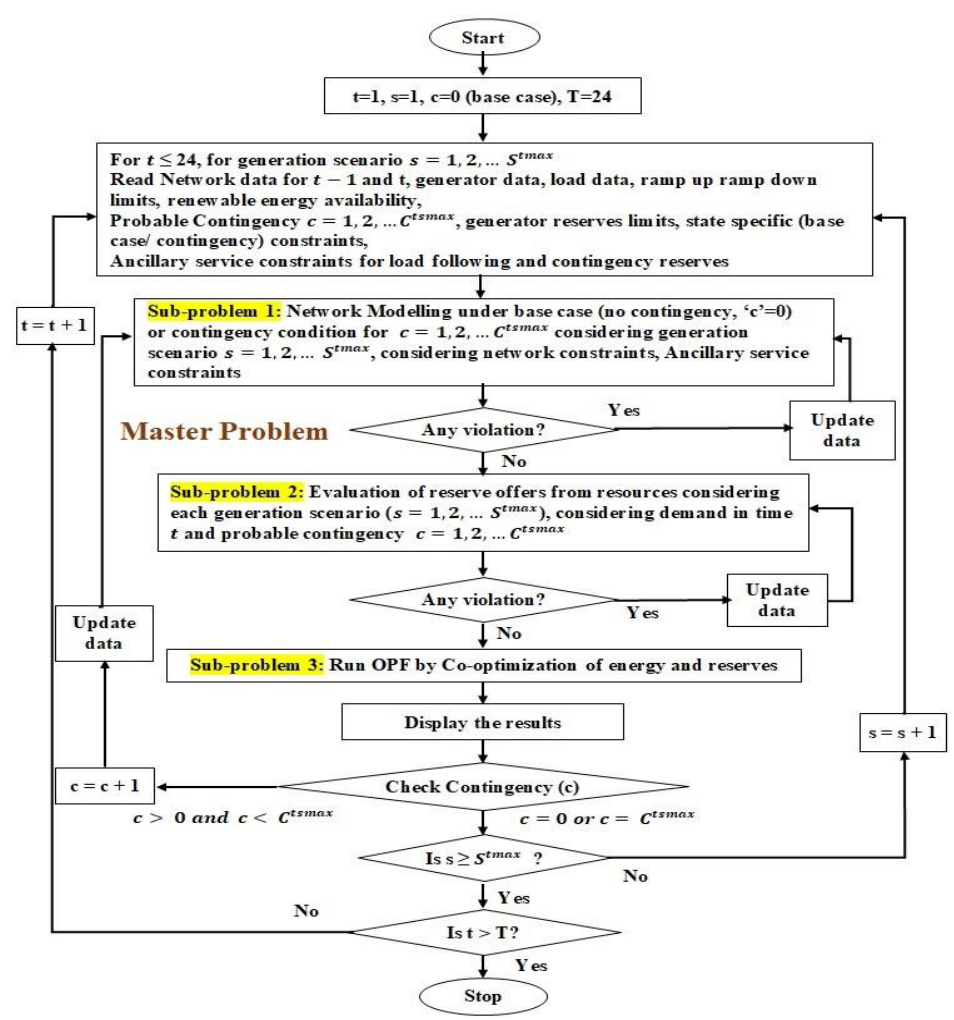
Figure 7. Flowchart for multiperiod stochastic security-constrained economic dispatch (SSCED). The Master problem consists of three